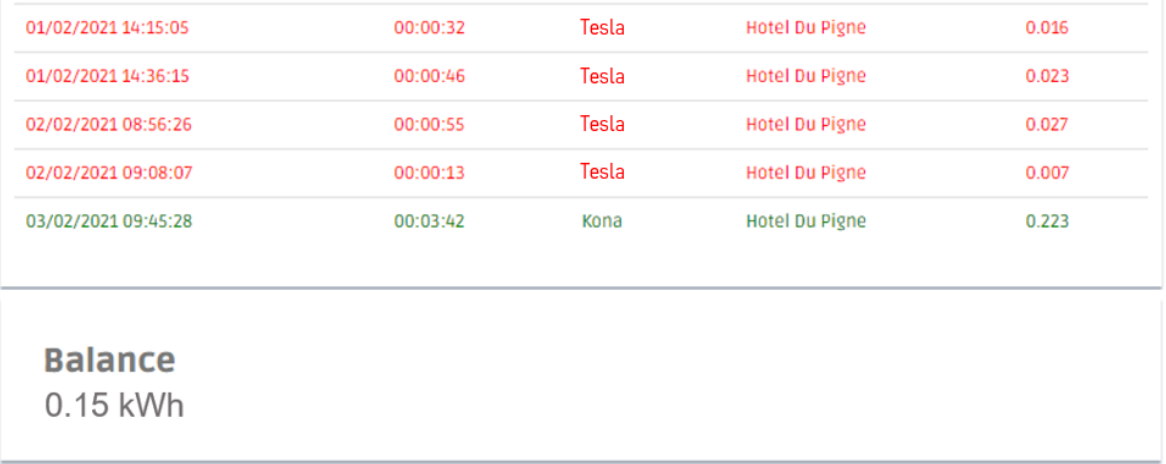
Figure 19. The web interface of the Hotel Aiguille de la Tza.